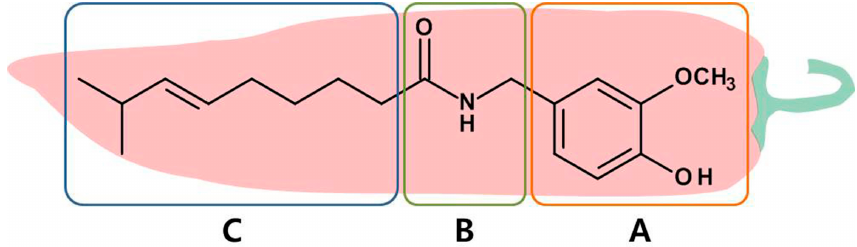
Figure 1. Chemical structure of capsaicin, the primary ingredient of chili pepper, and its three important regions, namely A (aromatic head), B (amide linkage) and C (hydrophobic tail) depicted in different colored boxes.